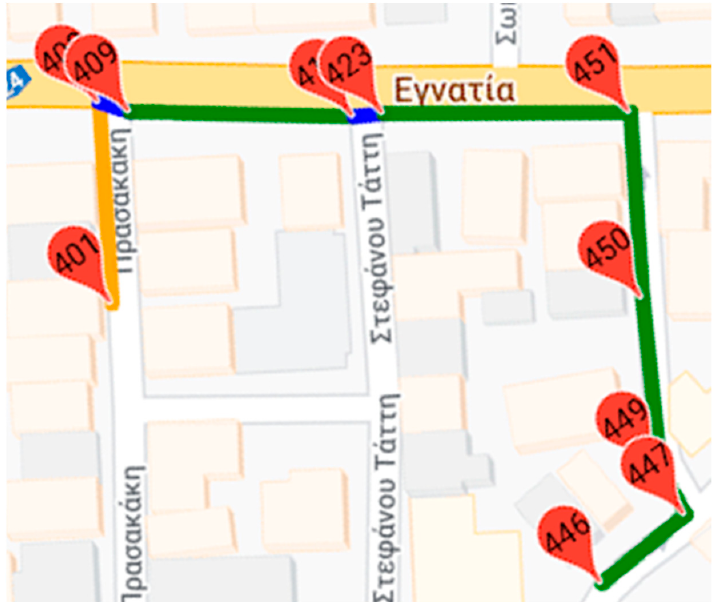
Figure 8. Most accessible path between nodes 401 and 446 using 2nd version of the algorithm.